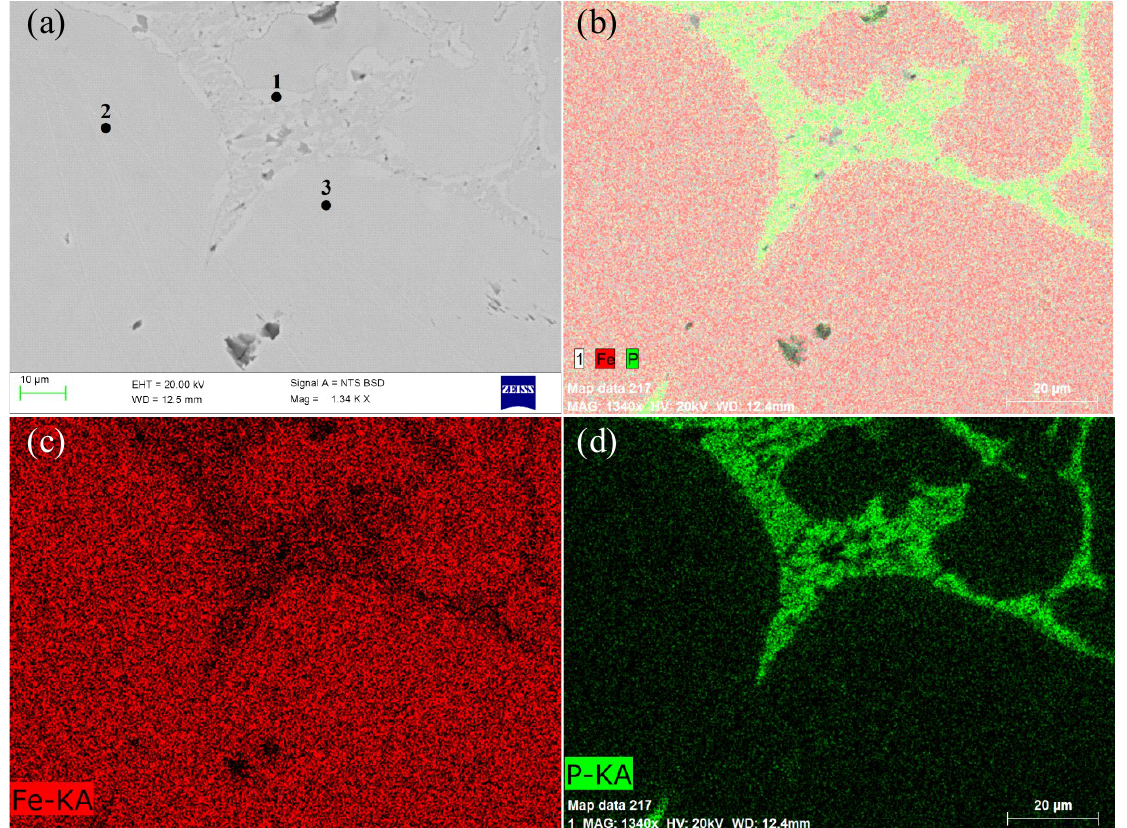
Figure 12. SEM–EDS images of metal phase: ( a ) SEM image; ( b ) the surface scanning analysis of Fe and P elements; ( c ) the surface scanning analysis of Fe elements; and ( d ) the surface scanning analysis of P elements.